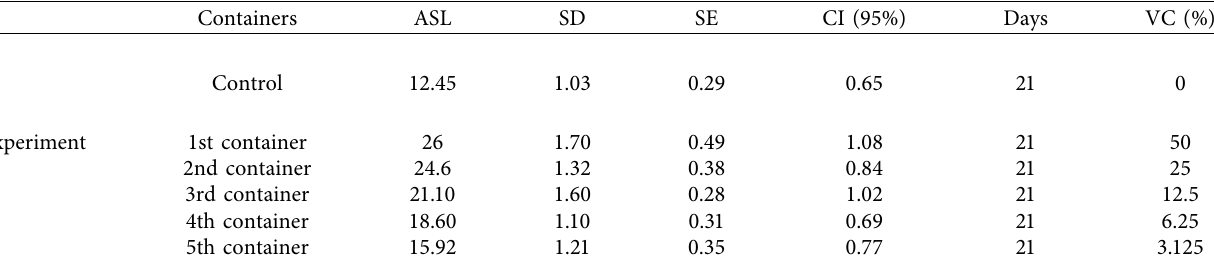
Table 8: Shoot length at the 3rd